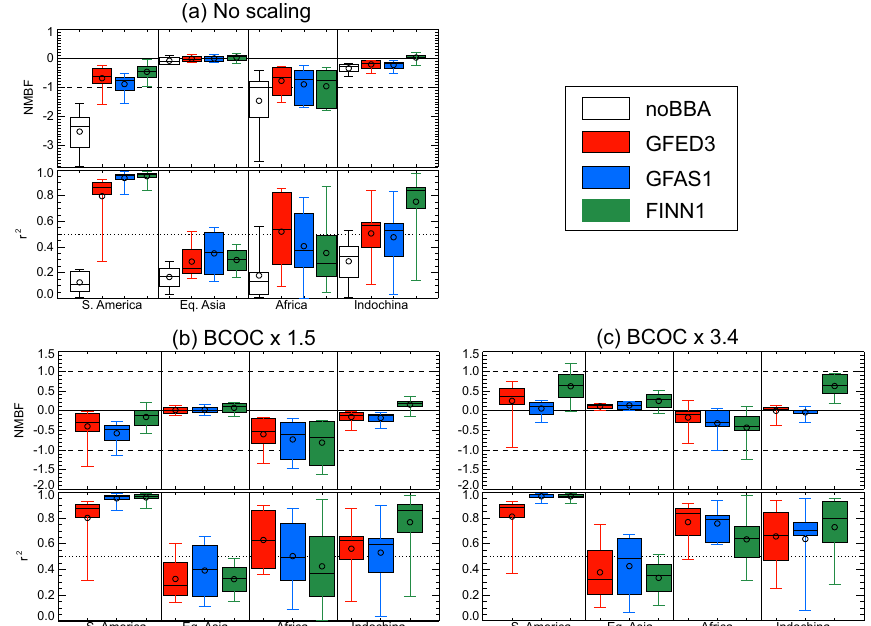
Figure 6. Box-and-whisker plots of the normalised mean bias factor (NMBF) and Pearson’s correlation coefficient ( r 2 ) between modelled and observed multi-annual monthly mean AOD at 440nm for AERONET stations located in South America (eight sites), equatorial Asia (four sites), Africa (six sites) and Indochina (nine sites). Results are shown for four model simulations: without fires (white), and with each of the three biomass burning emissions inventories – GFED3 (red), GFAS1 (blue), and FINN1 (green). (a) No scaling applied to the fire emissions, (b) particulate (BC / OC) fire emissions scaled up globally by a factor of 1.5, and (c) particulate (BC / OC) fire emissions scaled up globally by a factor of 3.4. The dashed lines indicate NMBFs of − 1 and 1, which equate to an underestimation and overestimation, respectively, of a factor of 2. The dotted line indicates an r 2 value of